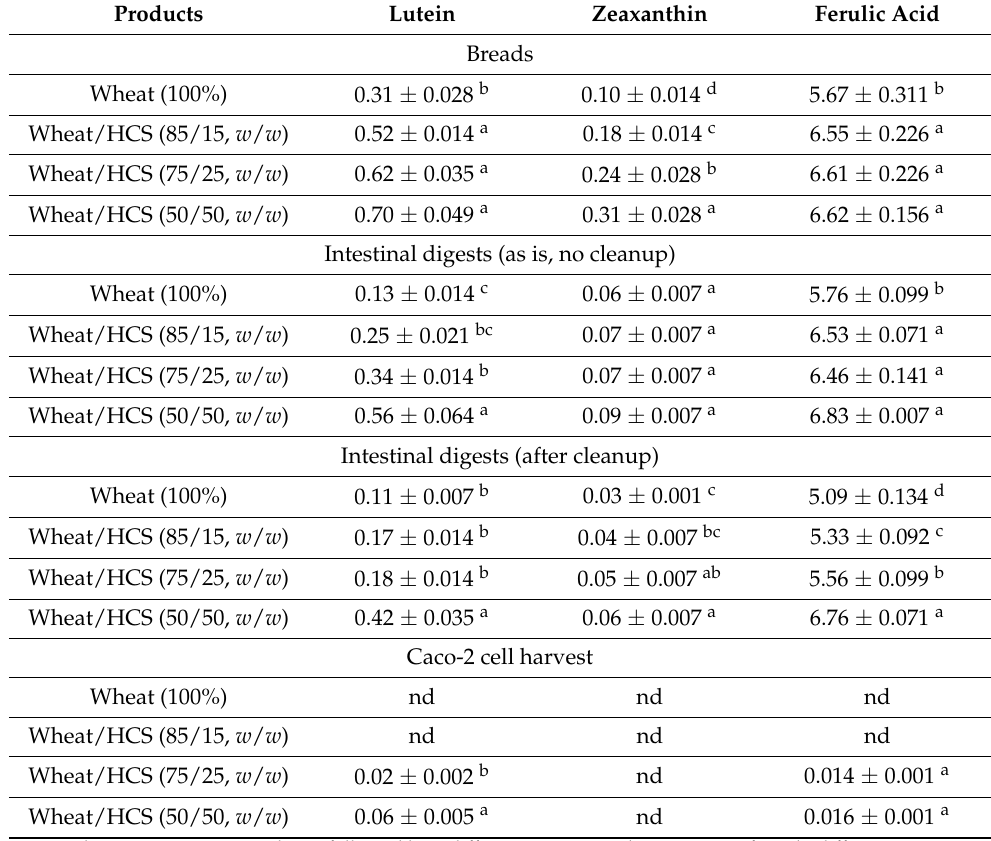
Table 3. Actual concentration of lutein, zeaxanthin, and ferulic acid in breads, their digesta without and with cleanup, and Caco-2 cell harvest ( µ g/g, as is basis, Mean ± SD) x . Products Lutein Zeaxanthin Ferulic Acid Breads Wheat (100%) 0.31 ± 0.028